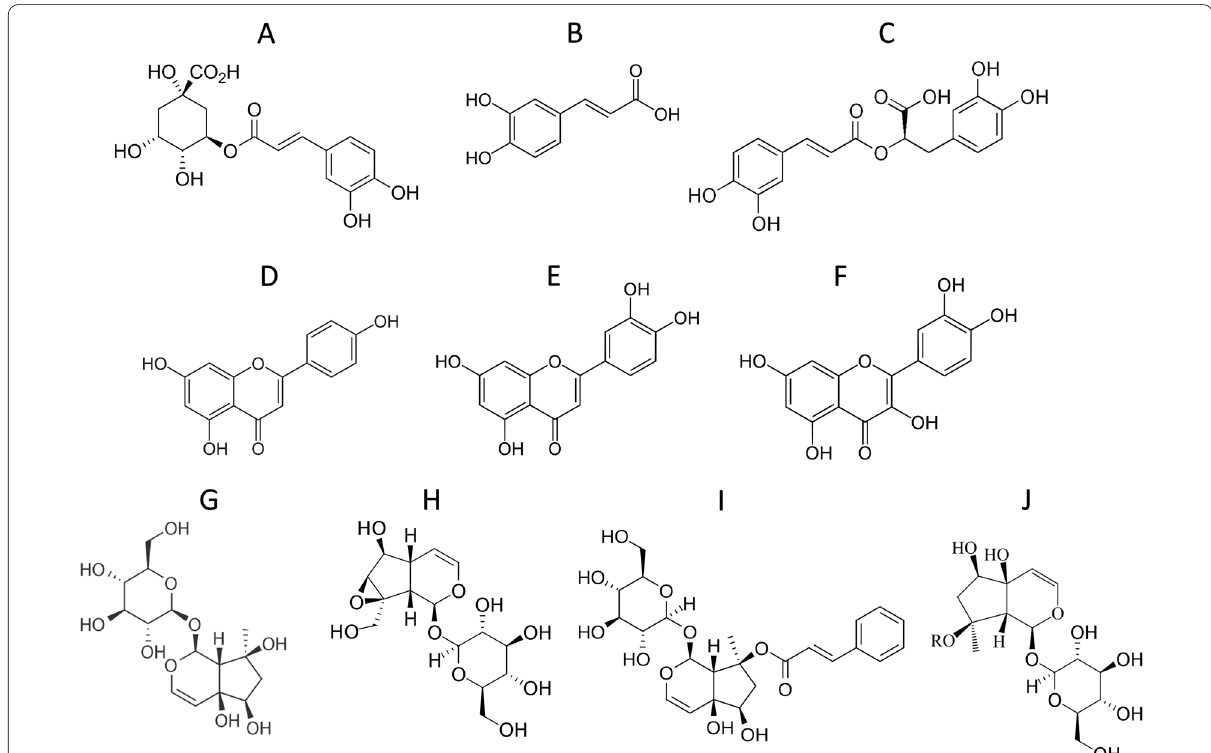
Fig. 1 Chemical structures of the main phytochemicals from A. integrifolia analyzed by HPLC. A chlorogenic acid; B caffeic acid; C rosmarinic acid; D apigenin; E luteolin; F quercetin; G harpagide; H aucubin; I catalpol; J 8‑ O ‑acetyl‑harpagoside (R